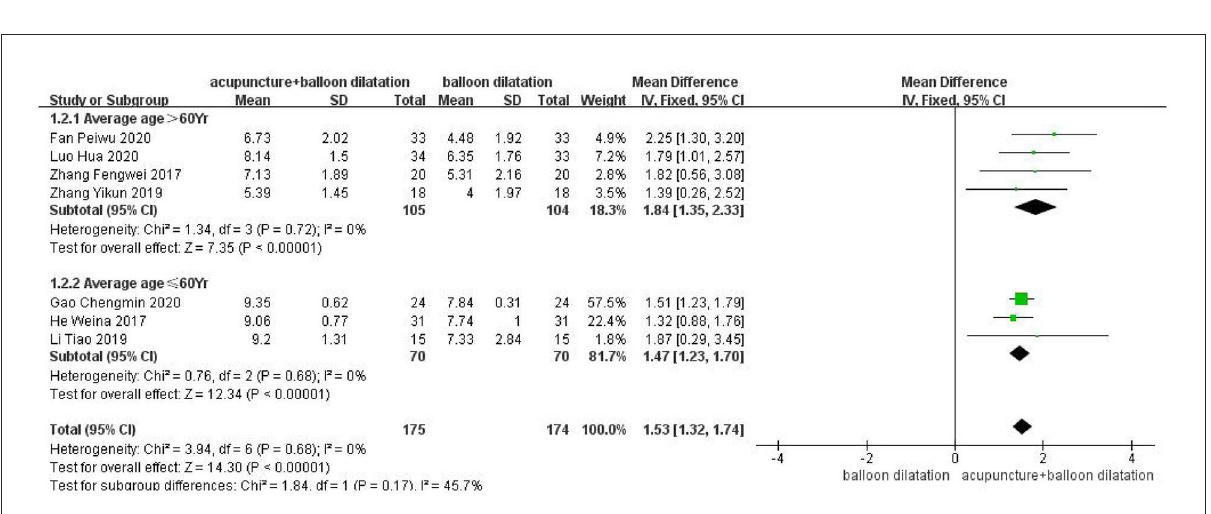
FIGURE7 Forest plot for subgroup analysis for the average age: the average age >60 Yr vs. the average age ≤ 60